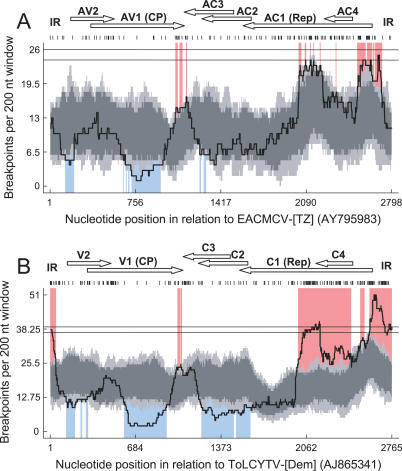
The Distribution of Recombination Breakpoints Detected within (A) DNA-A Sequences of Bipartite Begomovirus and (B) DNA-A-Like Sequences of Monopartite BegomovirusesAll estimated breakpoint positions are indicated by small vertical lines at the top of the graph. A 200-nucleotide window was moved along the alignment one nucleotide at a time and the number of breakpoints detected within the window region was counted and plotted (solid line). The horizontal lines at the top of each graph indicate 99% and 95% confidence thresholds for globally significant breakpoint clusters. Light and dark grey areas respectively indicate local 99% and 95% breakpoint clustering thresholds, taking into account local regional differences in sequence diversity that influence the ability of different recombination detection methods to identify recombination breakpoints. Red areas indicate recombination hot-spots, while blue areas represent recombination cold-spots. ORFs (horizontal arrows) and IR are represented on the top of the graph.